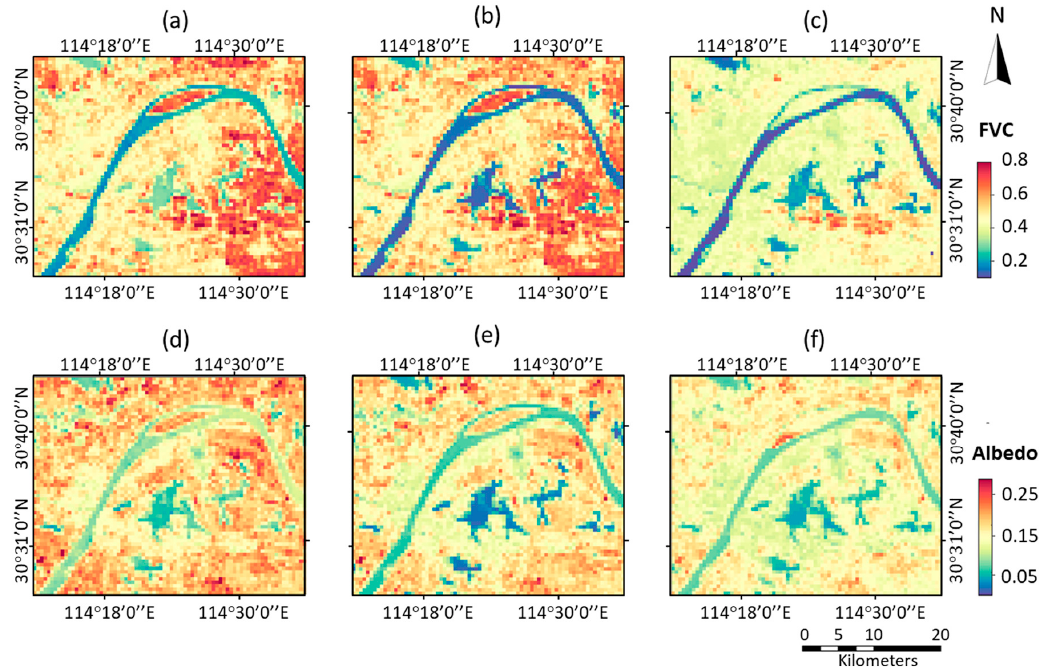
Figure 4. The spatial distributions of the indicators preserving evident seasonal variations. ( a – c ) Respectively represent the fractional vegetation cover (FVC) of summer, the transition season and winter; ( d – f ) albedo.